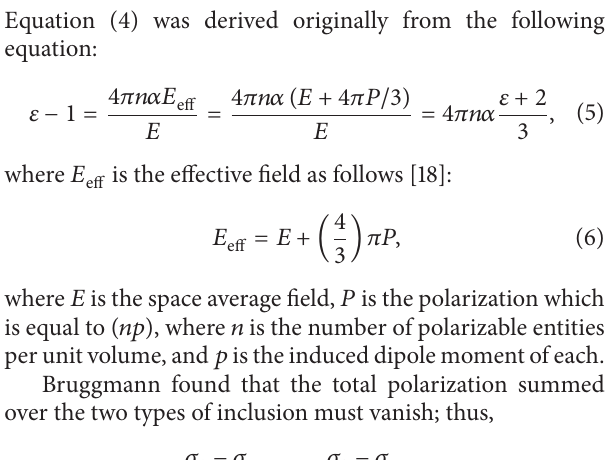
Figure 2: Procedure